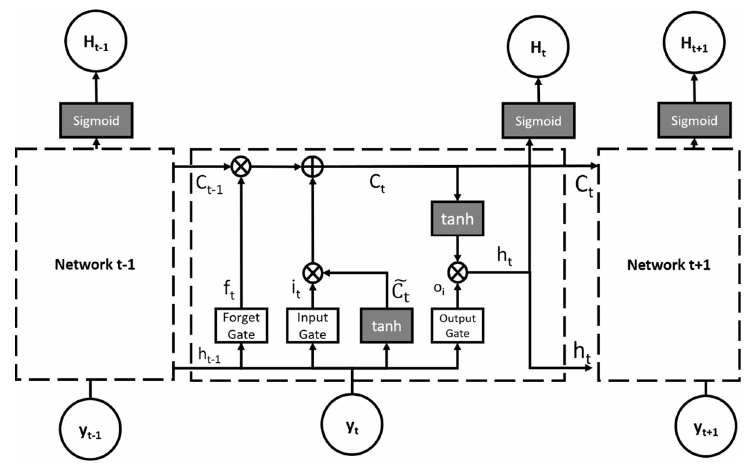
Figure 6. Adopted long-short-term memory (LSTM) neural network construction.